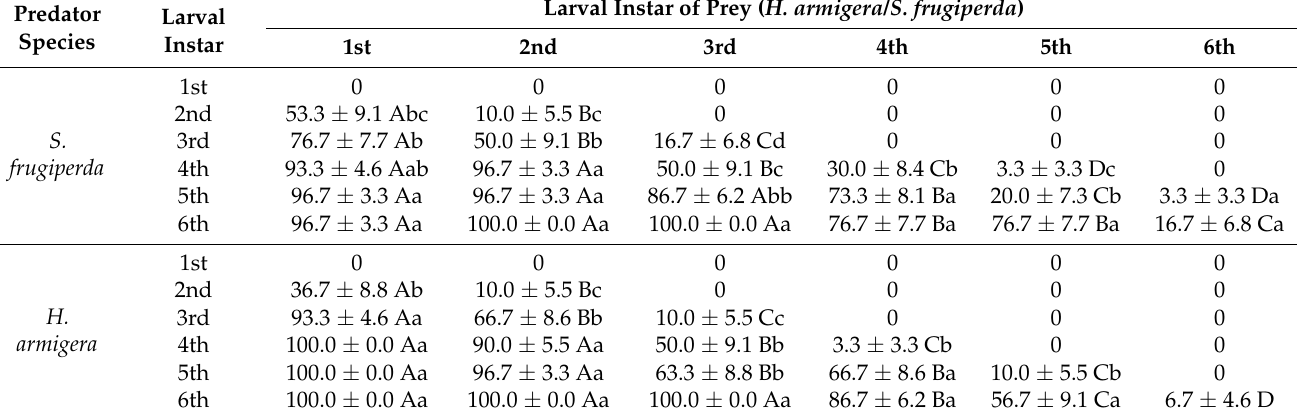
Table 1. Predation rates (%) of Spodoptera frugiperda or Helicoverpa armigera on different instar larvae of the other species.